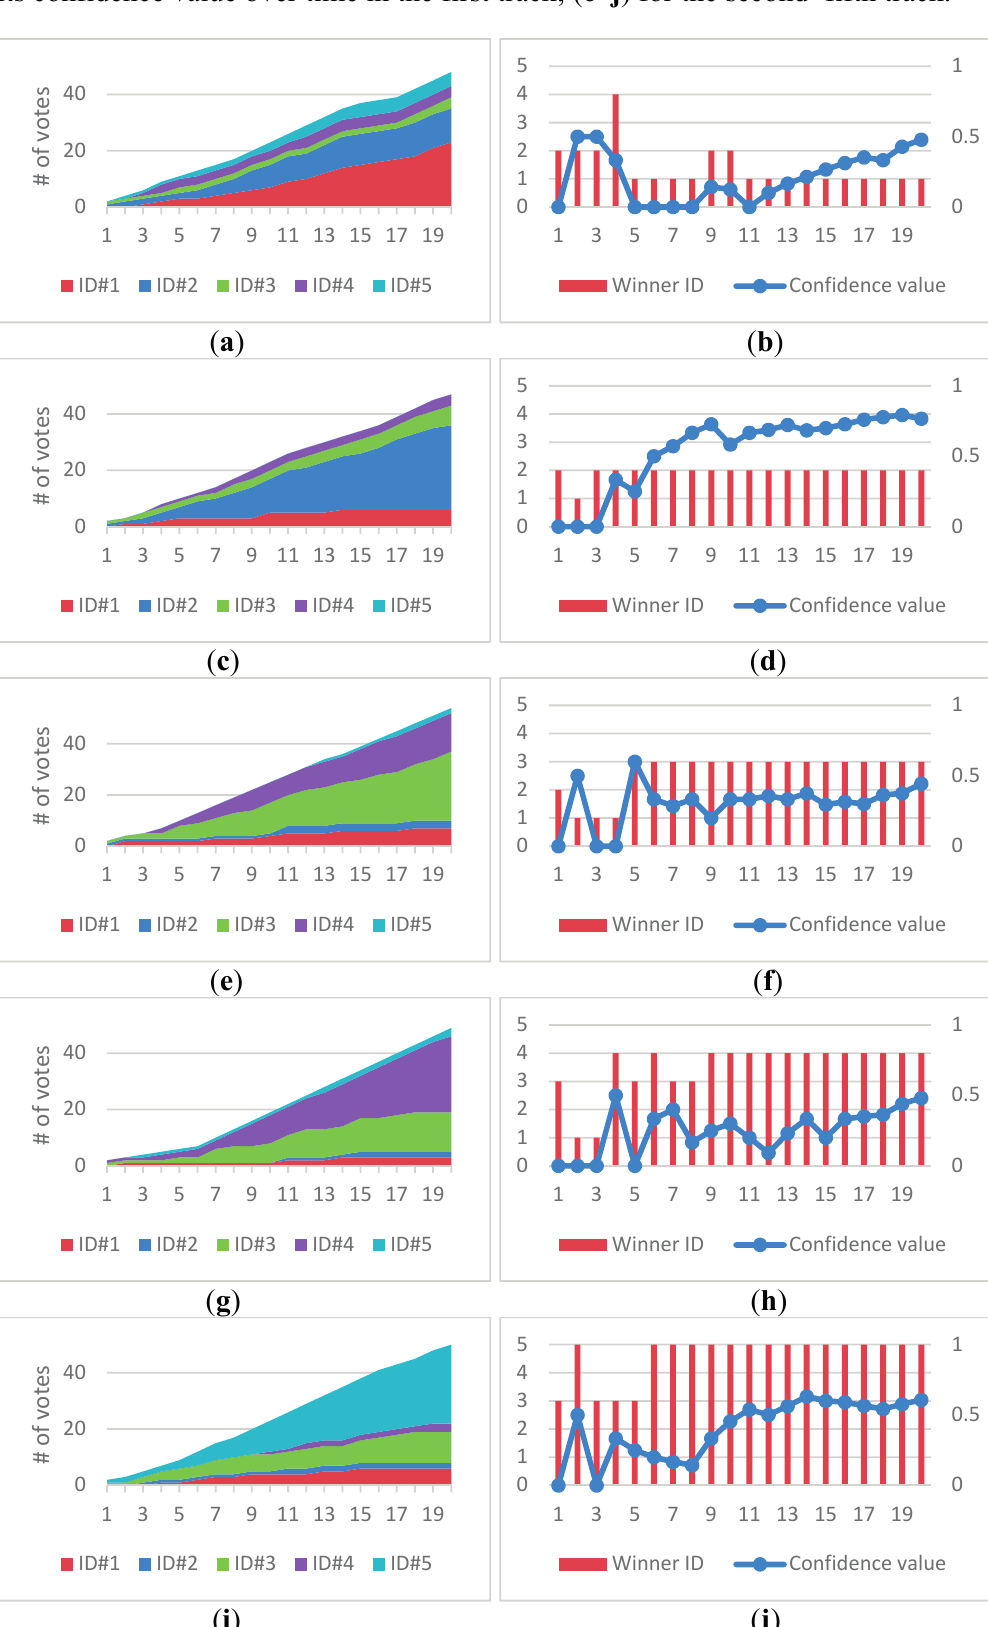
Figure 9. Track-based voting for the human identification in five tracks with distinct IDs. ( a ) the voting result over time in the first track; ( b ) the winner ID with the highest votes and its confidence value over time in the first track; ( c – j ) for the second~fifth